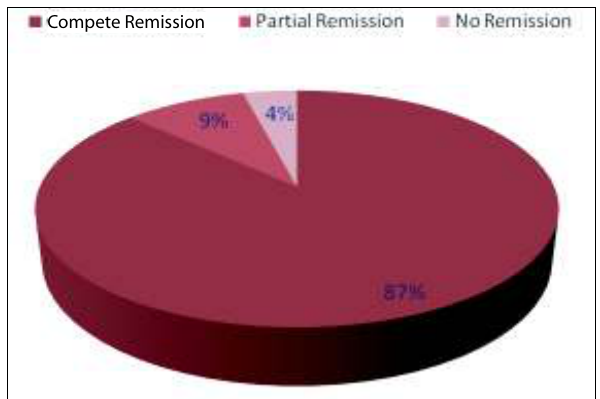
Fig 3. Bone marrow remission pattern after induction therapy